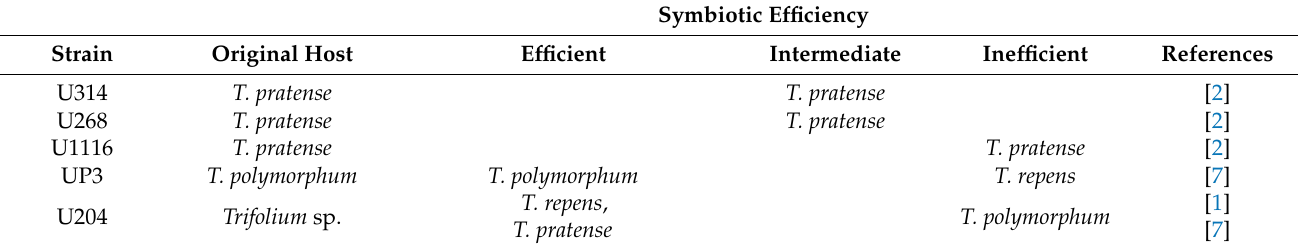
Table 1. Rhizobia strains used in this